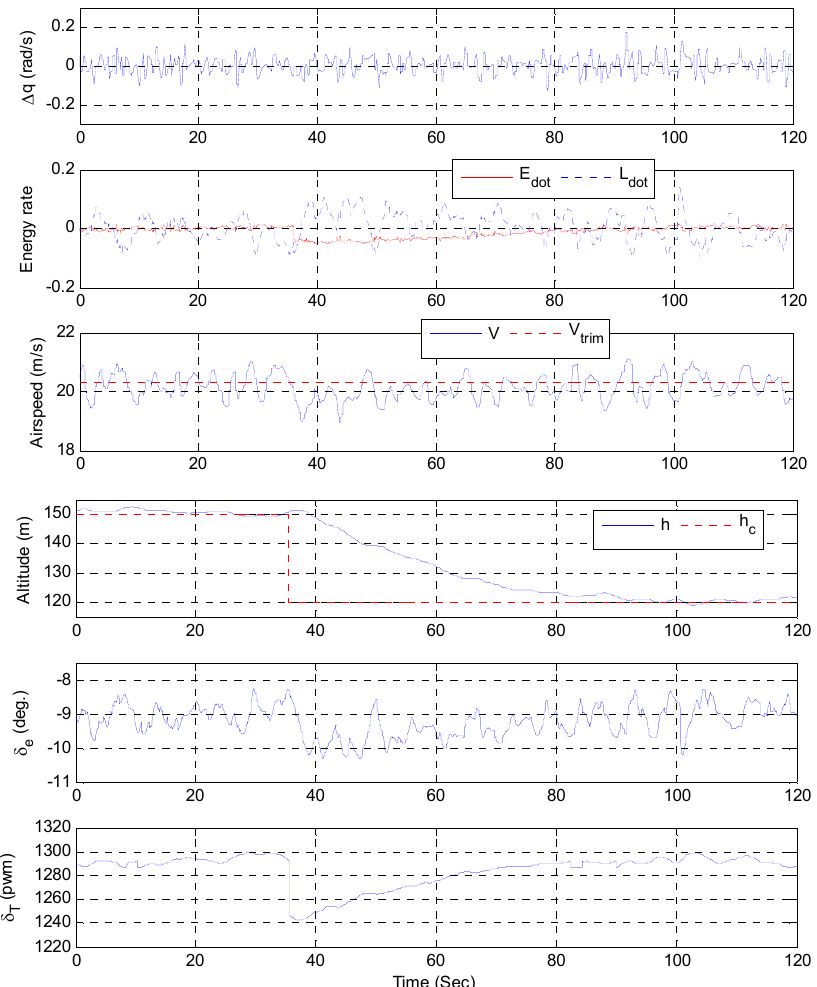
Figure 18. Simulation results of descending with the presence of wind .